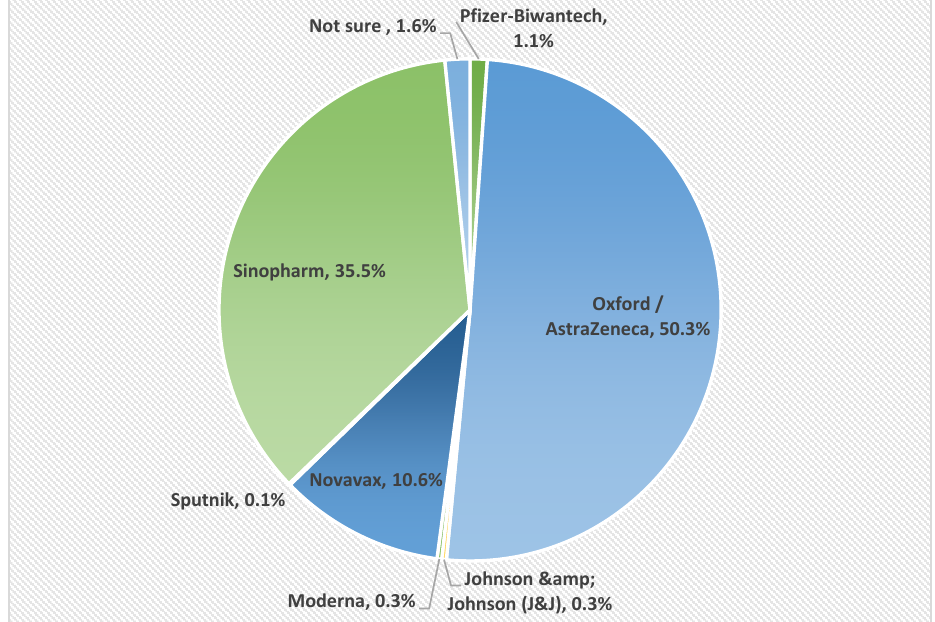
Figure 3. Type of vaccine COVID-19 administrated in CHD patients who received the vaccine (n = 614).